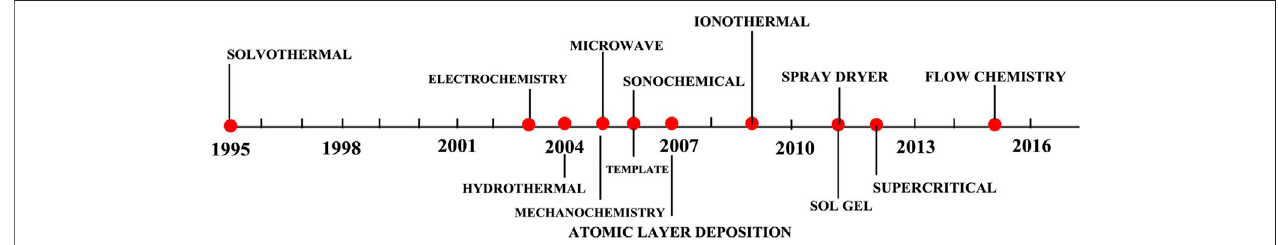
FIGURE 4 | Timeline of the synthesis methods developed for the synthesis of MOFs in the past two decades. Adapted with permission from (Olajire, 2018). Copyright 2018, Elsevier.